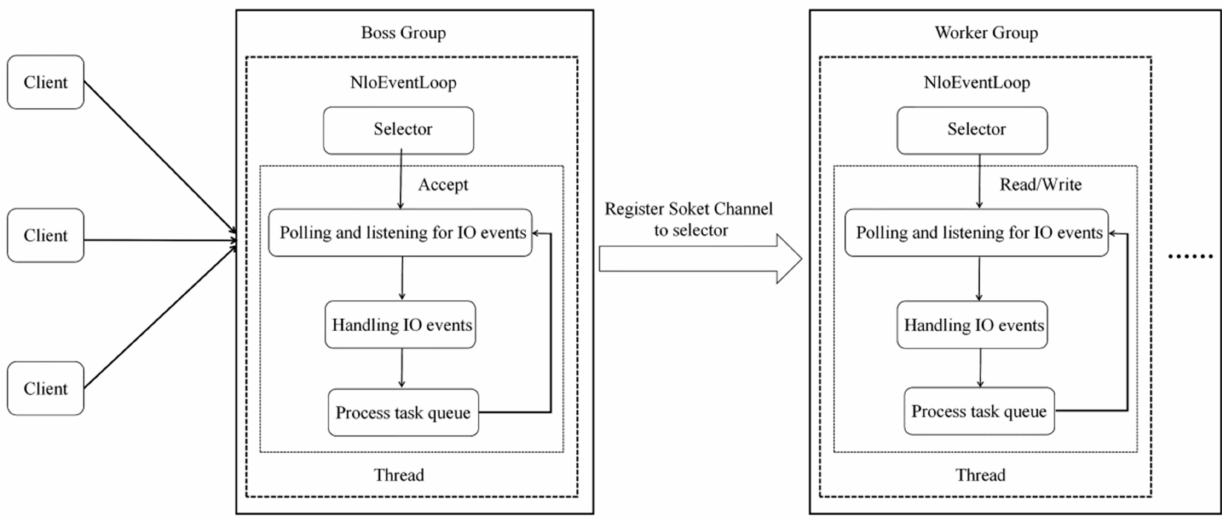
Figure 4. Data monitoring flow chart.